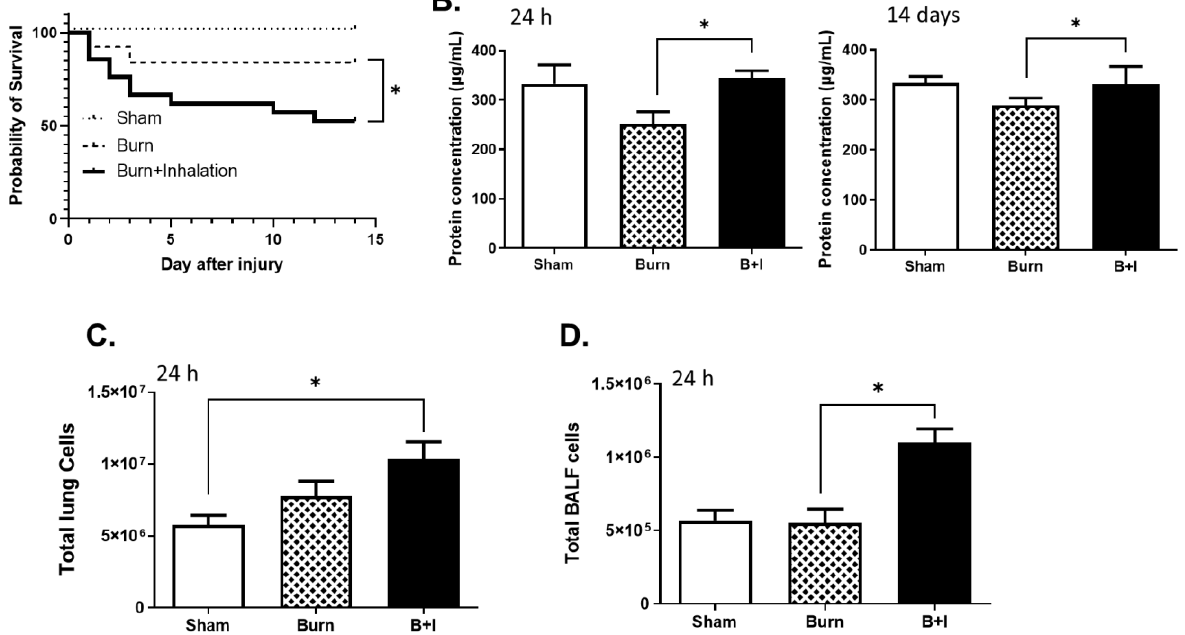
Figure 1. Combined burn and smoke inhalation (B+I) injury leads to higher mortality than burn injury alone, with elevated levels of cells and protein within the lung tissue and airway. Mice underwent either B+I, burn, or sham injury. Lung tissue or BALF was harvested at 24 h or 14 days after injury. ( A ) Survival of mice from injury to 14 days after injury was evaluated (n = 12 per group); ( B ) total proteins in bronchoalveolar lavage fluid (BALF) were assayed by BCA (n = 6 per group); ( C , D ) total immune cell numbers within the total lung tissue ( C ) and BALF ( D ) were evaluated at 24 h post-injury (n = 6 per group) by flow cytometry. In each case, data are presented +/ − SEM, with significance represented as * p < 0.05. Data are representative of three independent experiments.